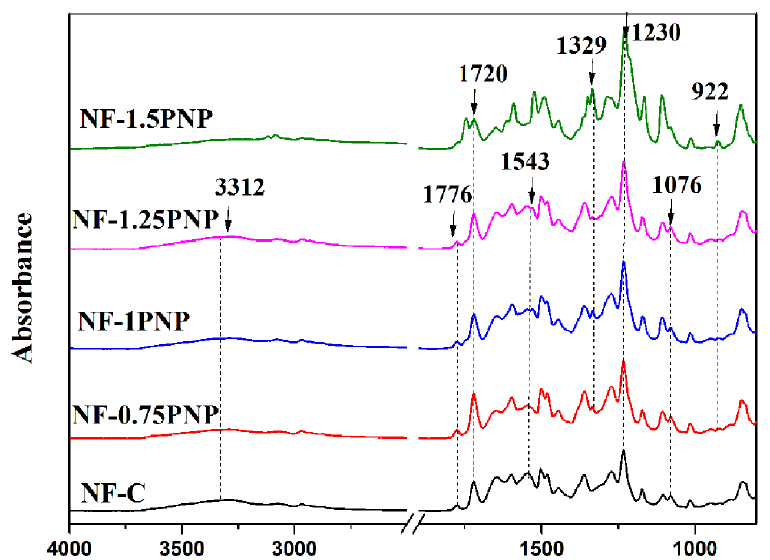
Figure 3. The ATR-FTIR spectra of the NF-C, NF-0.75PNP, NF-1PNP, NF-1.25PNP, and NF-1.5PNP membranes.